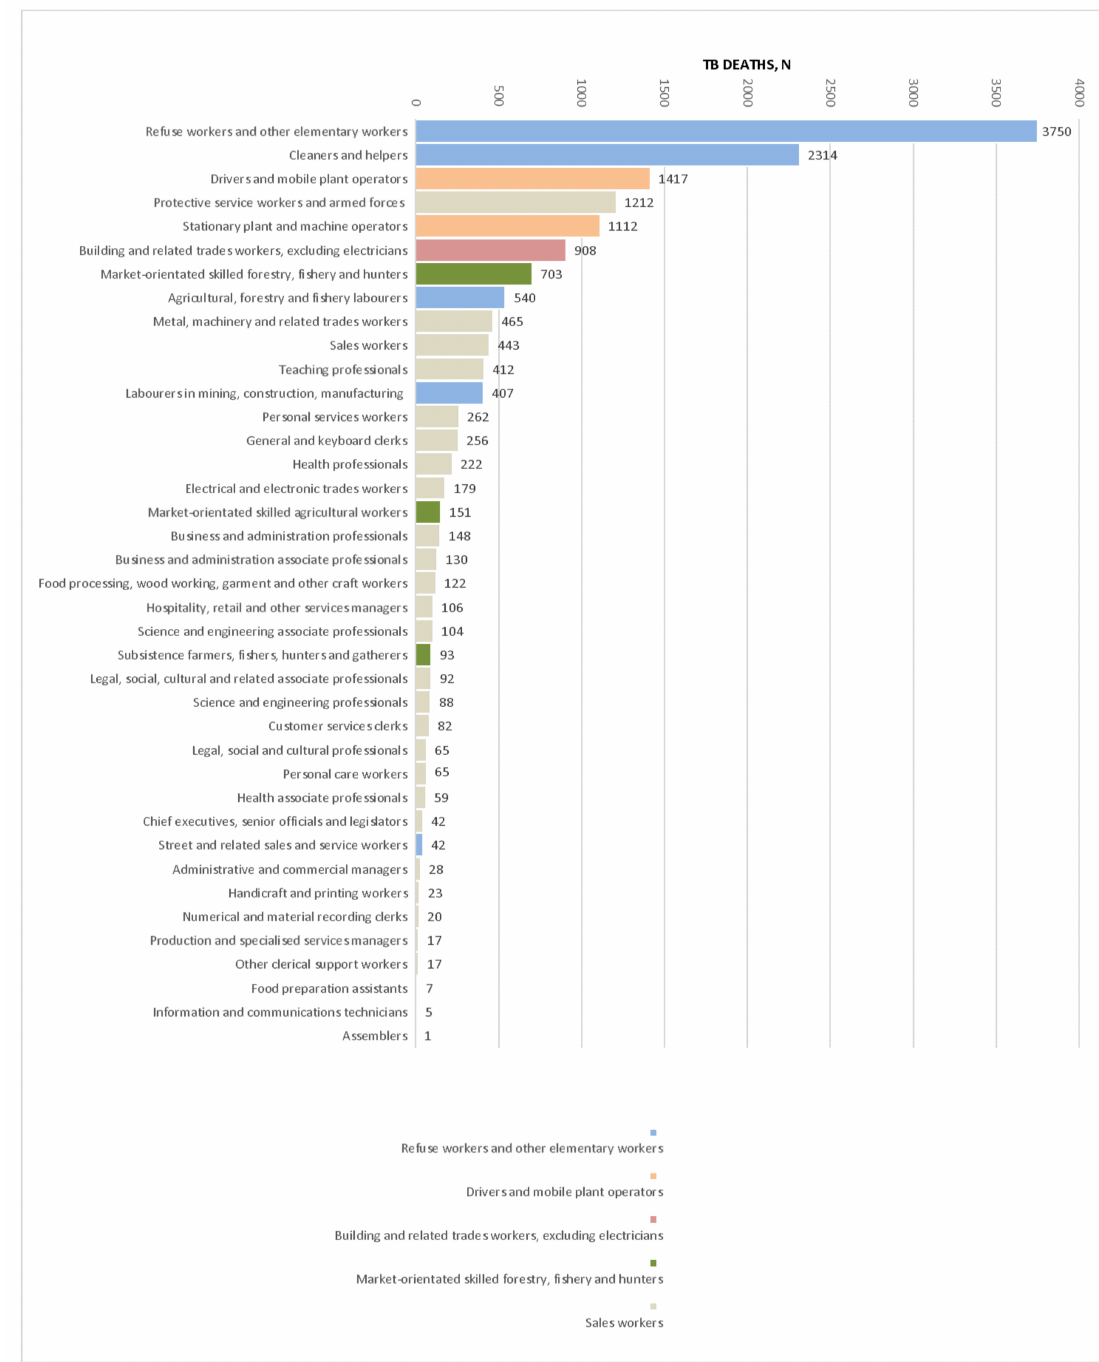
Figure 3. Number of TB deaths by occupation